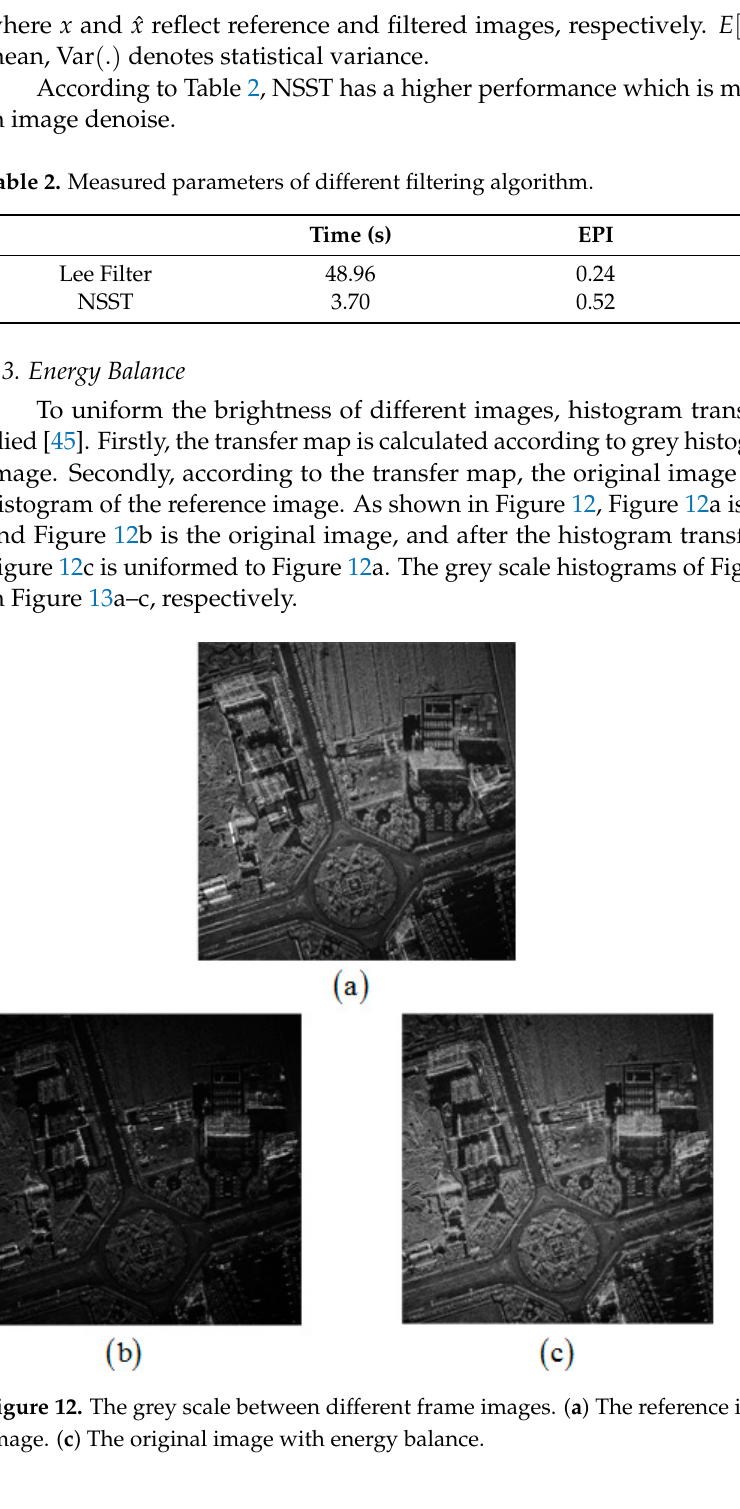
Figure 13. The grey scale histogram. ( a ) The grey scale histogram of Figure 12a. ( b ) The grey scale histogram of Figure 12b. ( c ) The grey scale histogram of Figure 12c. In addition to generating ViSAR, all aspects of SAR images can be fused in one im- age after histogram transfer algorithm. Compared with a single SAR image, the image fusion result can not only improve image signal-to noise ratio but also solve shadow oc- clusion issues that arise from the typical side-looking geometry [1]. Therefore, the image